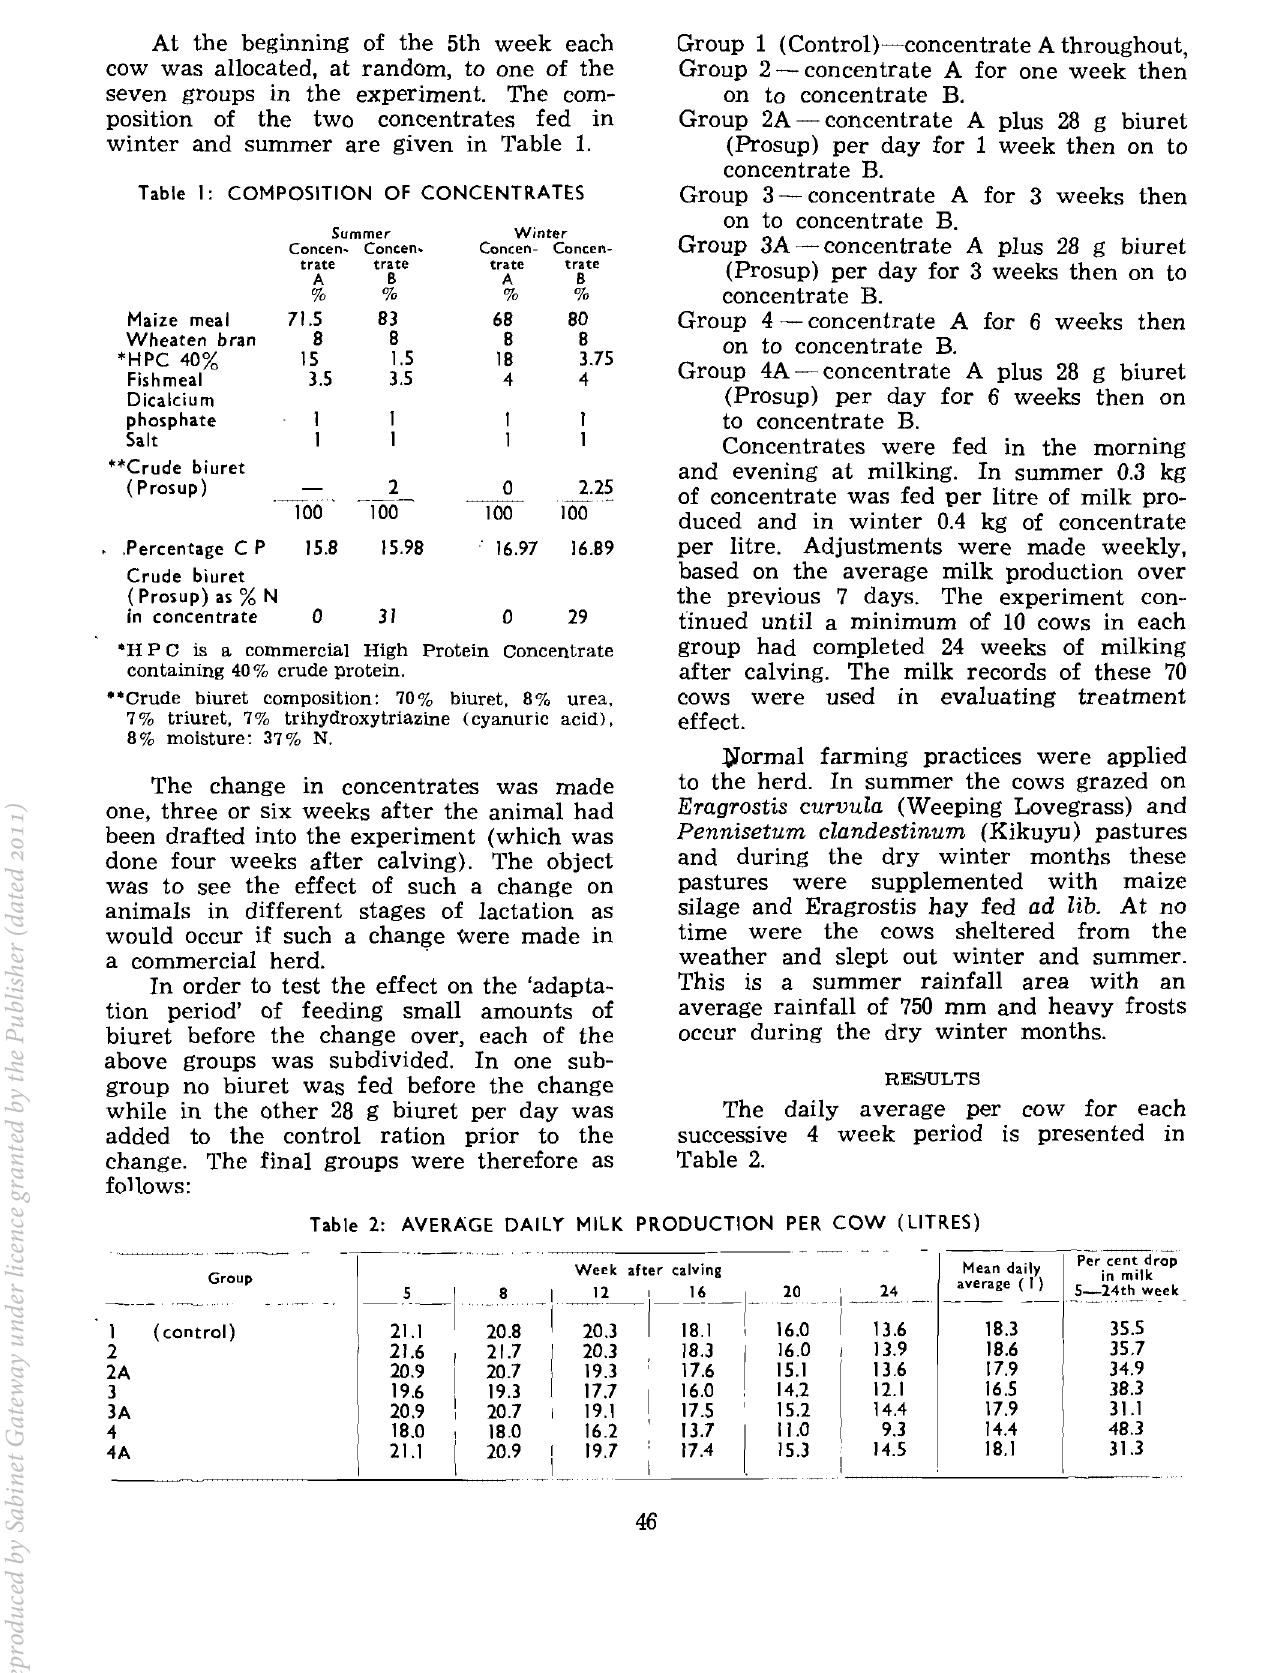
Table 2: AVERAGE DAILY MILK PRODUCTION PER COW